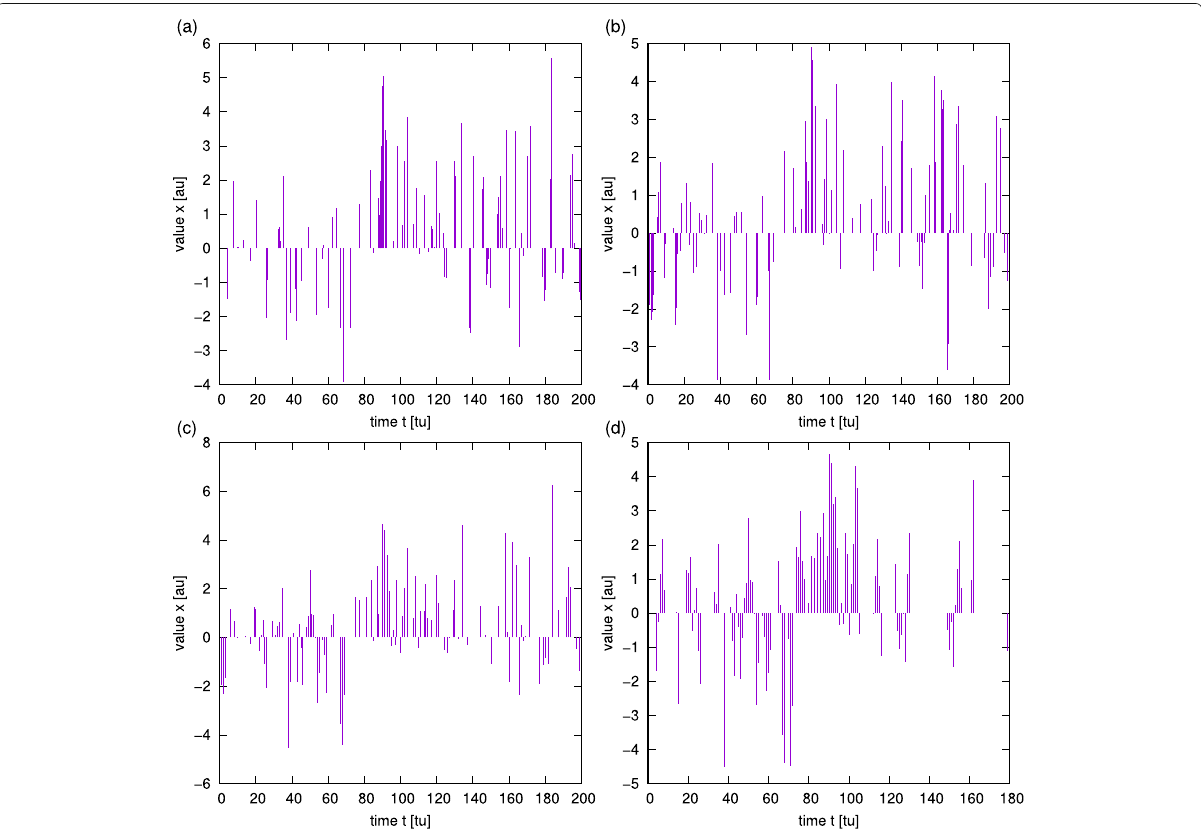
Fig. 3 Single realizations of the signals. a Ideal random and independent samples from continuous time with a continuous distribution of sampling intervals, b random samples from continuous time with a continuous distribution of sampling intervals with processor dead time, c independent outliers in equidistant time with a discrete distribution of sampling intervals, and d correlated data gaps in equidistant time with a discrete distribution of sampling intervals (au, amplitude unit; tu, time